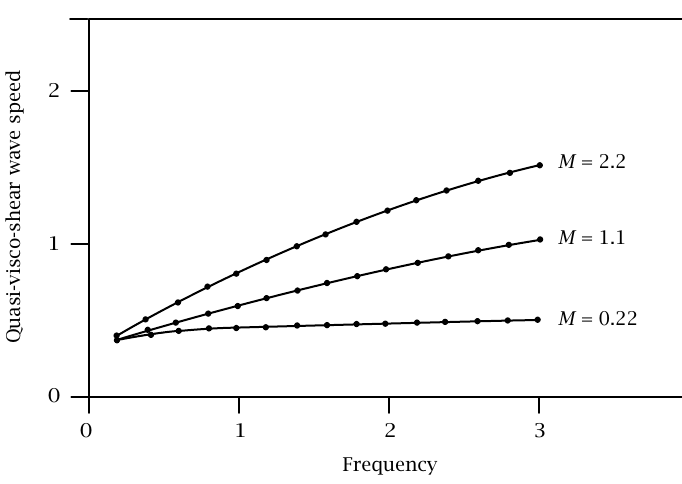
Figure 7.2 . Plot of quasi-visco-shear wave speed against real frequency ω .